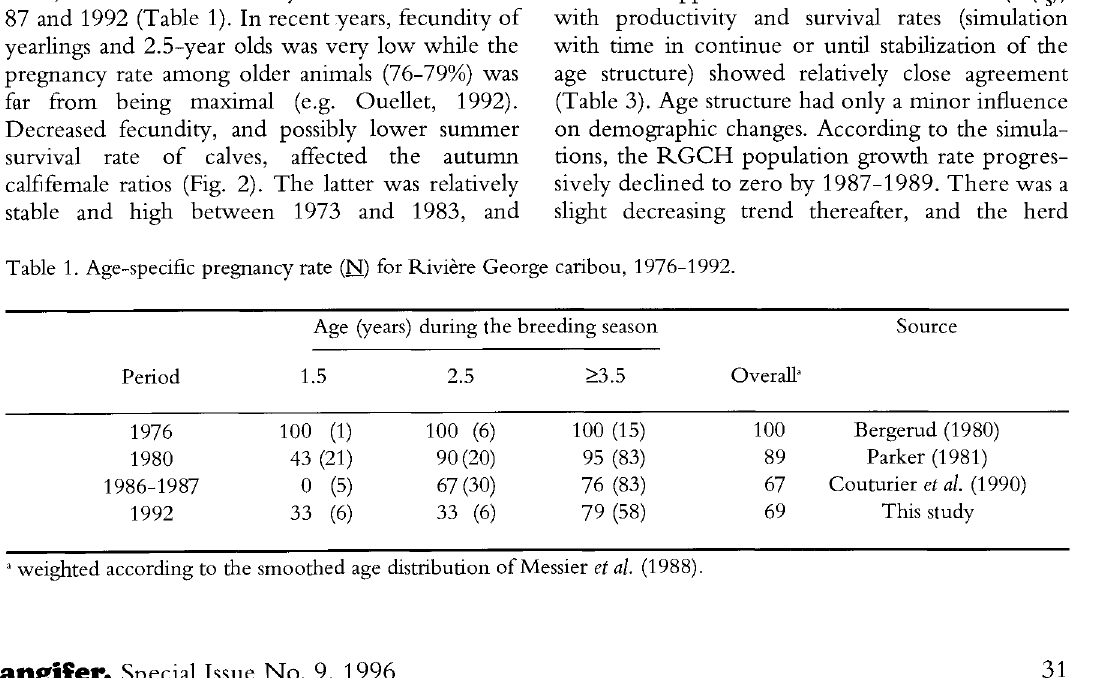
Table 1. Age-specific pregnancy rate (N) for Rivière George caribou, 1976-1992.